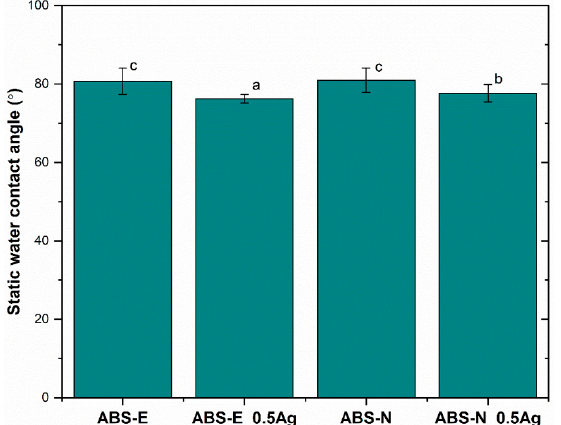
Figure 3. The static water contact angle of pure polymers and polymers containing silver nanoparticles. Statistically significant differences ( p < 0.05) between the tested materials are marked a–c.